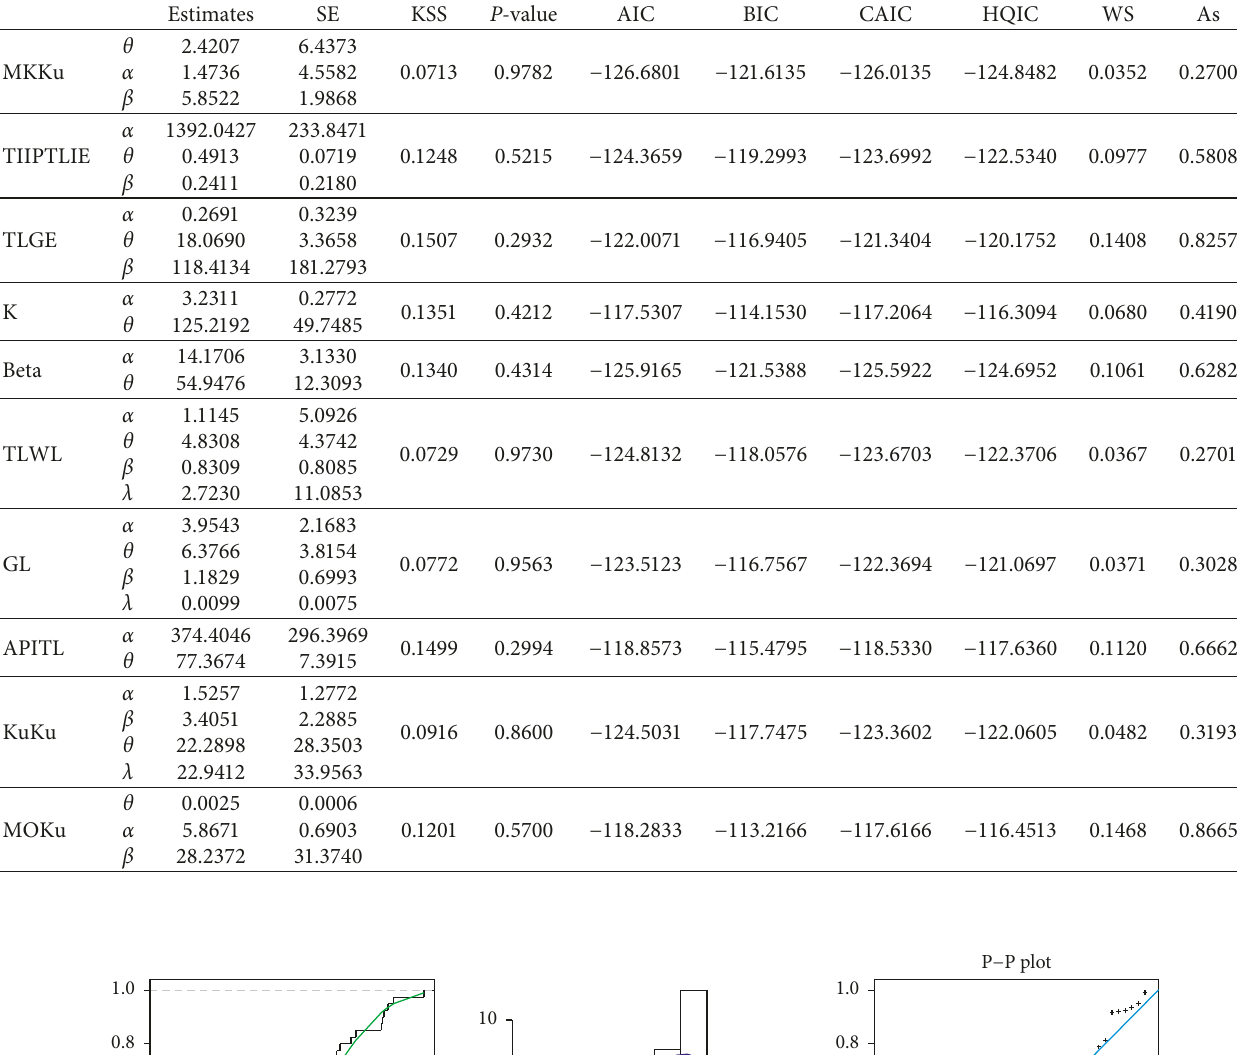
Table 3: MLE, SE, KS test, and P -values for COVID-19 data of Saudi Arabia.